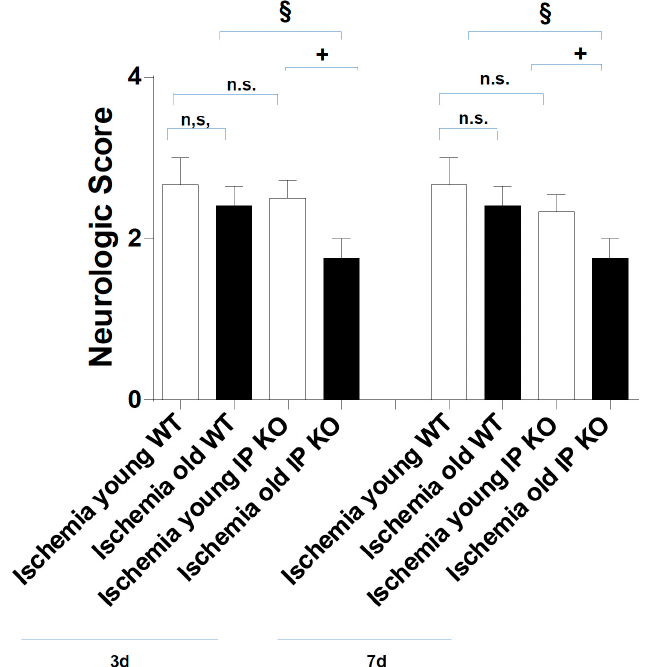
Figure 2. Effect of PGI2 IP receptor on locomotor activity after 12 min global ischemia and 3-day or 7-day reperfusion. Locomotor activity was assessed by a 5-point scale. Both young and aged ischemic IP KO mice were compared to their ischemic WT controls ( § p < 0.05, + p <0.05, n.s. = no significant). Data represent mean ± s.e.m. n = 6–8 per